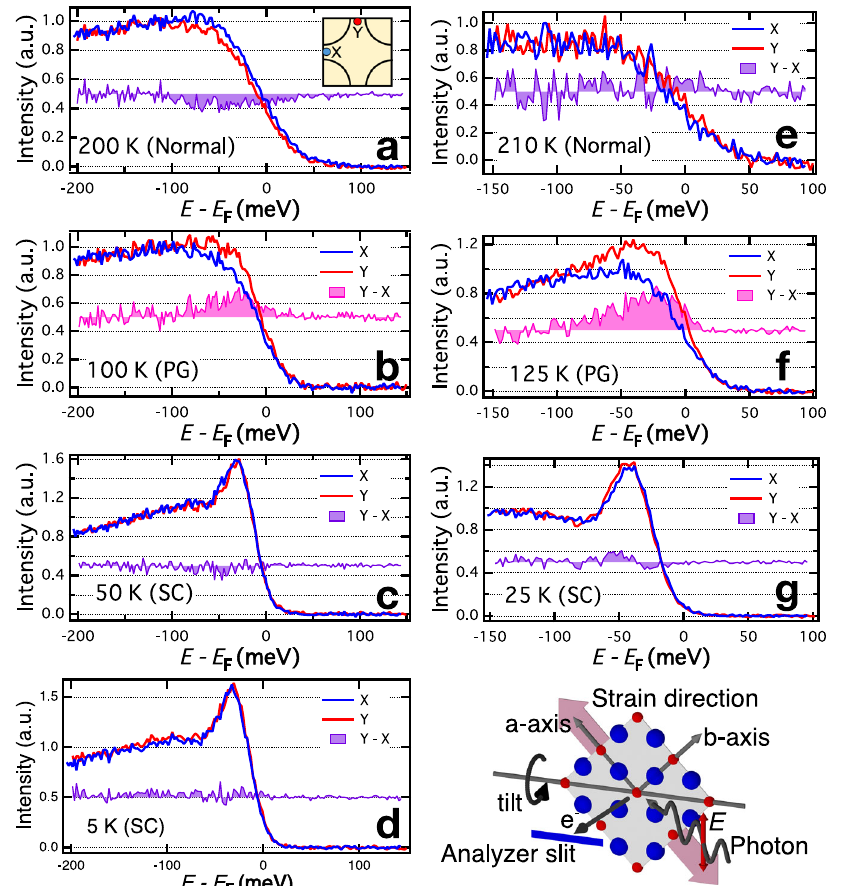
Fig. 1 Energy distribution curves (EDCs) of Pb-Bi2212 at various temperatures. The measurements were performed with decreasing temperature for a – d and increasing temperature for e – g . At each temperature, EDCs at the X and Y points and the difference between them are displayed. At each temperature, the spectra have been normalized at high energy in the displayed energy range. In the pseudogap state ( T = 100 and 125 K), the spectral intensities between the X and Y points are clearly different while they are nearly identical in the normal ( T = 200 and 210 K) and superconducting states ( T = 5, 25, and 50 K). Inset shows the experimental geometry including the crystallographic axes, the strain direction, light polarization, and the analyzer slit, which ensure the spectroscopic equivalence of the a -axis and b -axis